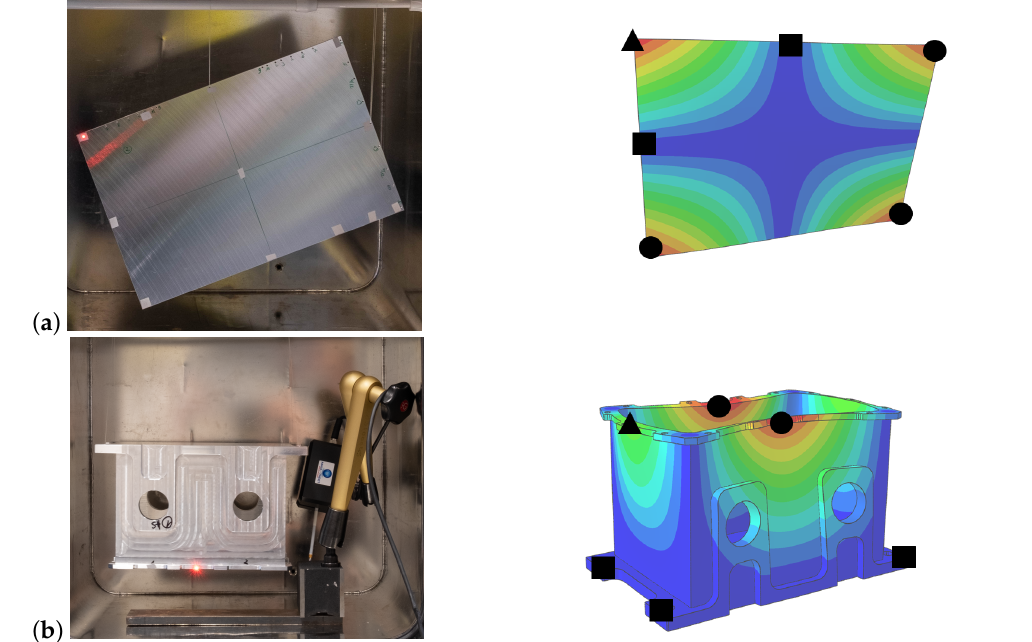
Figure 3. Experimental setup and positions of suspension ( ), measurement points ( ) and excitation points ( —measurement and excitation) on the first three eigenmodes of the rectangular aluminum plate ( a ) and the box component ( b